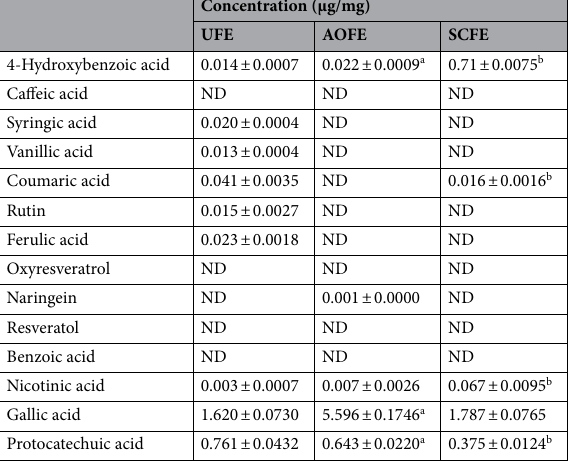
Table 2. Contents of quantified phenolic compounds contained in AOFE. Different superscript letters indicate significant differences in mean values at p < 0.05 between unfermented extracts and fermented extracts. Results are expressed as mean ± SD of three sample replicates. UFE, unfermented extracts; AOFE, A. oryzae fermented extracts; SCFE, S. cerevisiae extracts. ND, Not detected.